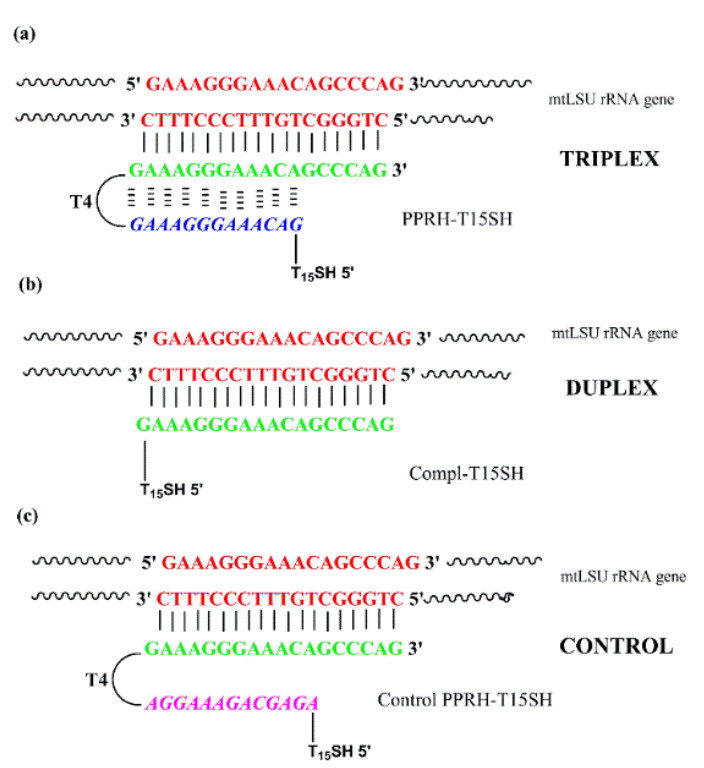
Figure 2. Sequences designed for use as bioreceptors in the SPR biosensor for the detection of the mtLSU rRNA gene of Pneumocystis jirovecii . ( a ) PPRH-T 15 SH capture probe recognizes the pyrimidine sequence of the mtLSU rRNA gene and forms a stable antiparallel triplex structure. ( b ) Complementary–T 15 SH forms a duplex structure with the pyrimidine sequence of the mtLSU rRNA. ( c ) Control PPHR-T 15 SH forms a duplex with the pyrimidine sequence of the mtLSU rRNA gene.